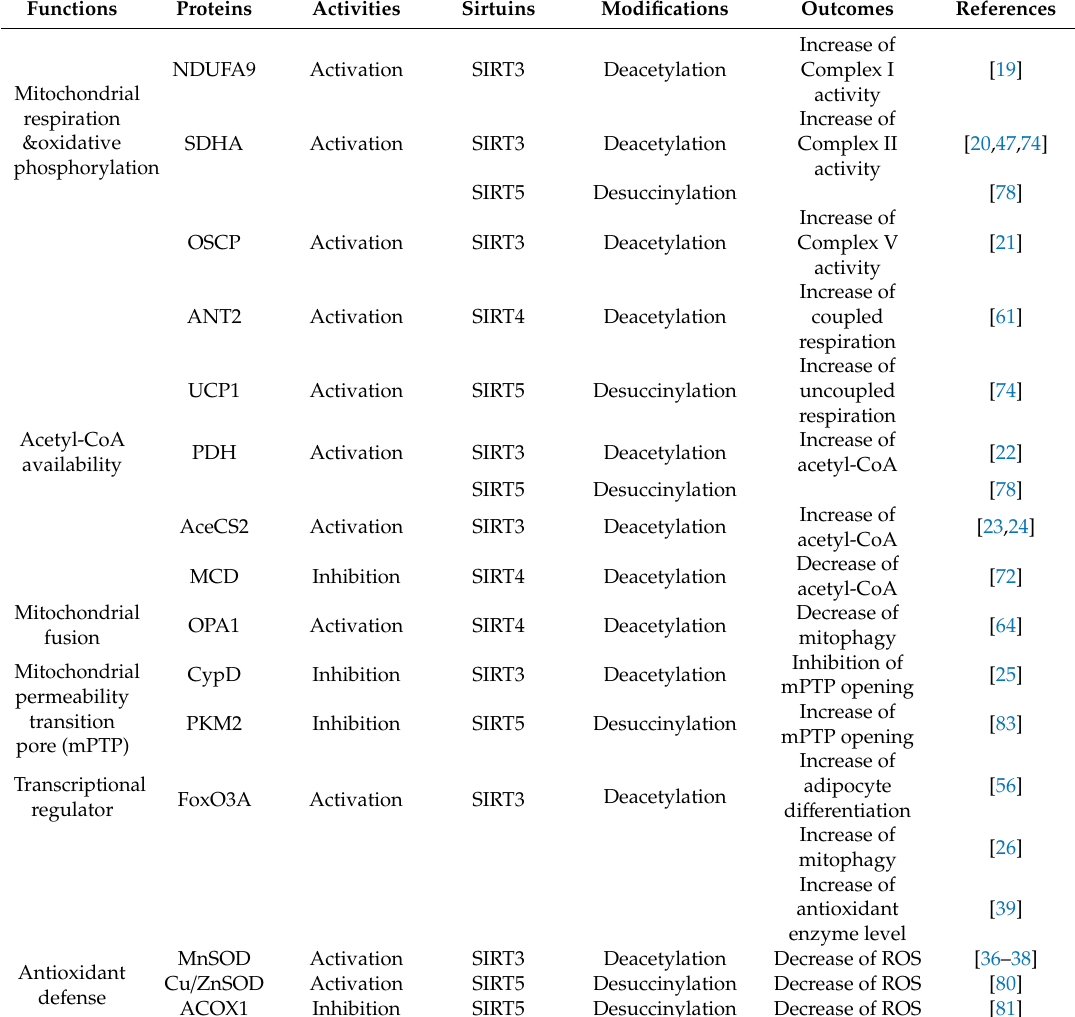
Table 1. Summary of metabolic functions regulated by mitochondrial